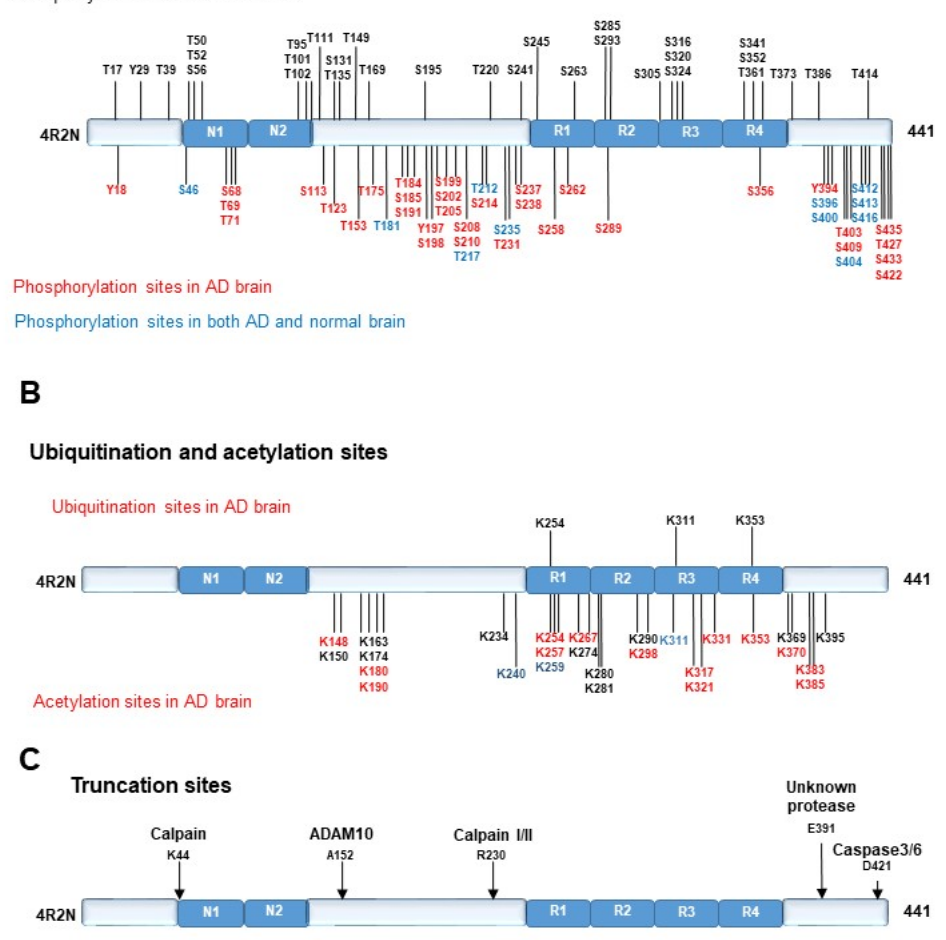
Figure 2. Post-translational modification of tau protein. ( A ) Putative phosphorylation sites of tau protein. Red color shows amino acids phosphorylated in AD brain, blue color in AD and normal brain, and black color in normal brain [10]. ( B ) ubiquitination sites (upper) observed in AD brain, and acetylation by p300 and CREB-binding protein (CBP) (black), only by p300 (red), or only by CBPblue) are also shown [15]. ( C ) Truncation sites of tau protein. The sequential truncation of tau can produce tau fragments. The cleavage of tau is more likely to happen when tau is detached from microtubules, either forming aggregates of each other, or becoming associated with proteins other than tubulin